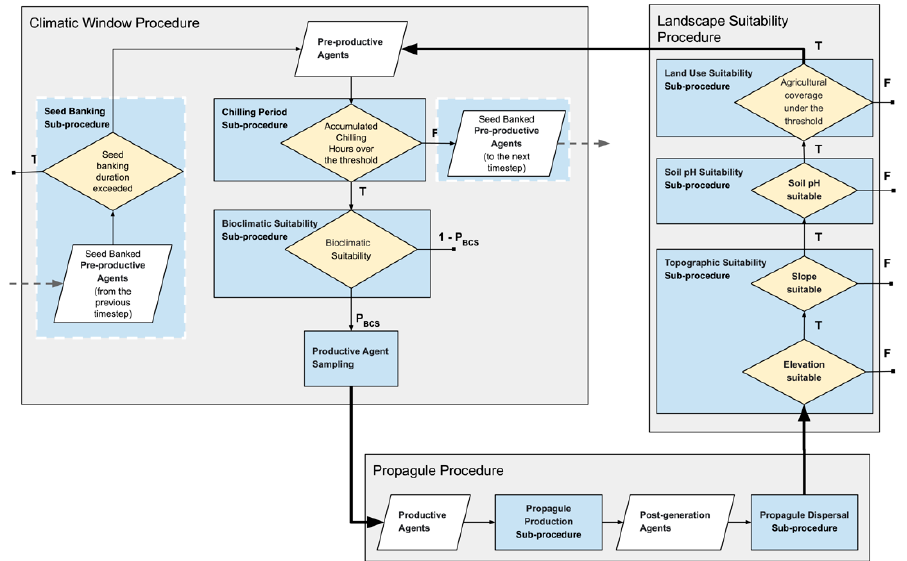
of a Figure 3. Work fl ow of the Agent-Based Component in a time step (P BCS : Bioclimatic Suitability of a cell).